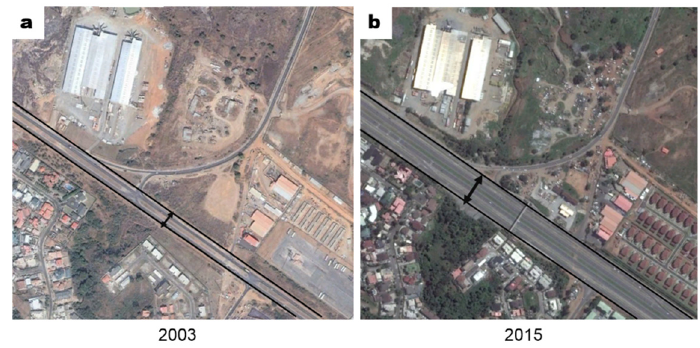
Figure 4. Example of the road expansion between 2003 ( a ) and 2015 ( b ) in the outer Northern Express Way of Abuja (image source Google Earth).